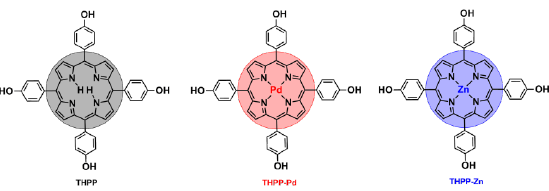
THPP-Pd-TiO 2 Figure 1. The XRD patterns of Gel-TiO 2 , THPP-TiO 2 , THPP-Pd-TiO 2 and THPP-Zn-TiO 2 . The surface areas of the photocatalyst play an important role in the hydrogen production in the photocatalytic system. Nitrogen adsorption – desorption isotherms were measured at 77 K to obtain the Brunauer – Emmett – Teller (BET) surface areas and pore size distributions of the samples (Figures S1 and S2 and Table S1). The BET surface areas of THPP-TiO 2 , THPP-Pd-TiO 2 , THPP-Zn-TiO 2 , Gel- TiO 2 , and, for comparison, P25-TiO 2 were evaluated to be 143.4, 166.1, 168.3, 162.9, and 55.4 m 2 g −1 , respectively. The results suggested that the sol-gel method could increase the BET surface areas of TiO 2 . In addition, the micro/mesoporous structure, comprising both micropores (1~2 nm) and mesopores (3~5 nm), could be observed in porphyrin-TiO 2 and Gel-TiO 2 materials, in contrast to that (29 nm) of mesoporous P25-TiO 2 , which shortened the transport length and contributed to the faster diffusion of the electrons from the bulk to the surface, thus inhibiting the charge recombination and increasing the catalytic efficiency. The morphologies of the as-prepared samples have been observed by the scanning electron microscopy (SEM) and transmission electron microscopy (TEM). The SEM image in Figure 2A